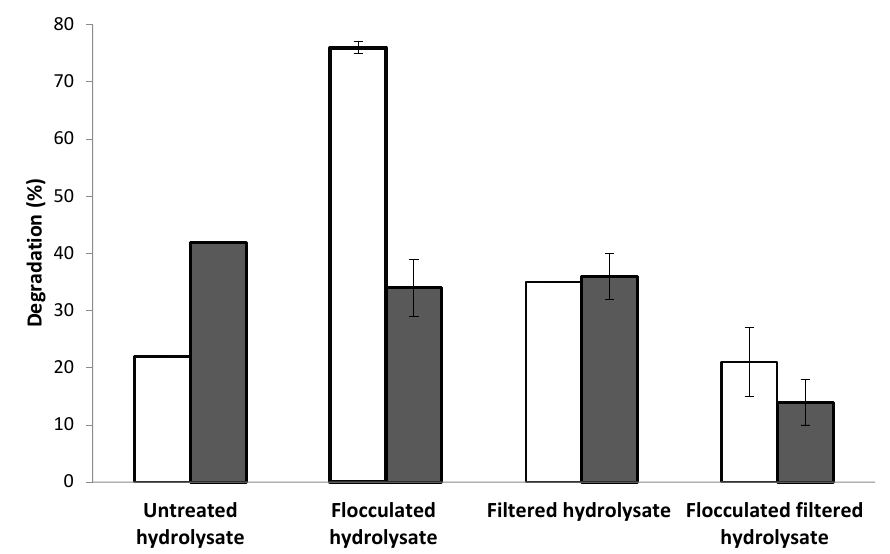
Figure 7. Degradation percentage of phenolic compounds by laccase enzymes in hydrolysates pre-treated by different methods. White: solid laccase; Black: liquid laccase.